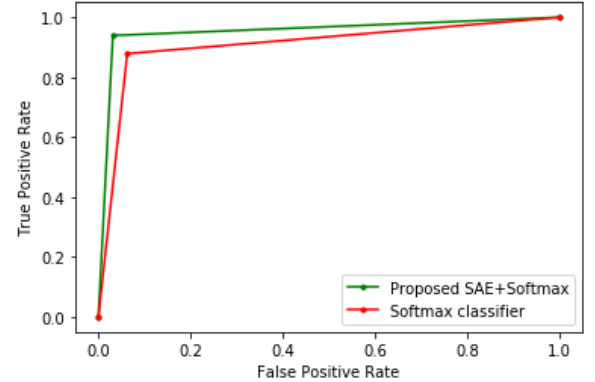
Electronics 2020 , 9 , x FOR PEER REVIEW